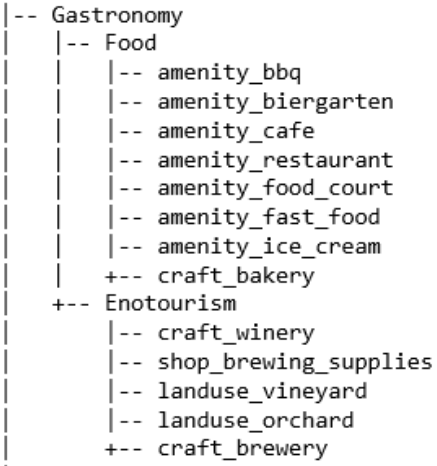
Figure 2. Sample chunk of the Activity tree, showing the main category “Gastronomy” , its subcate- gories “Food” and “Enotourism” and the OSM tags associated with